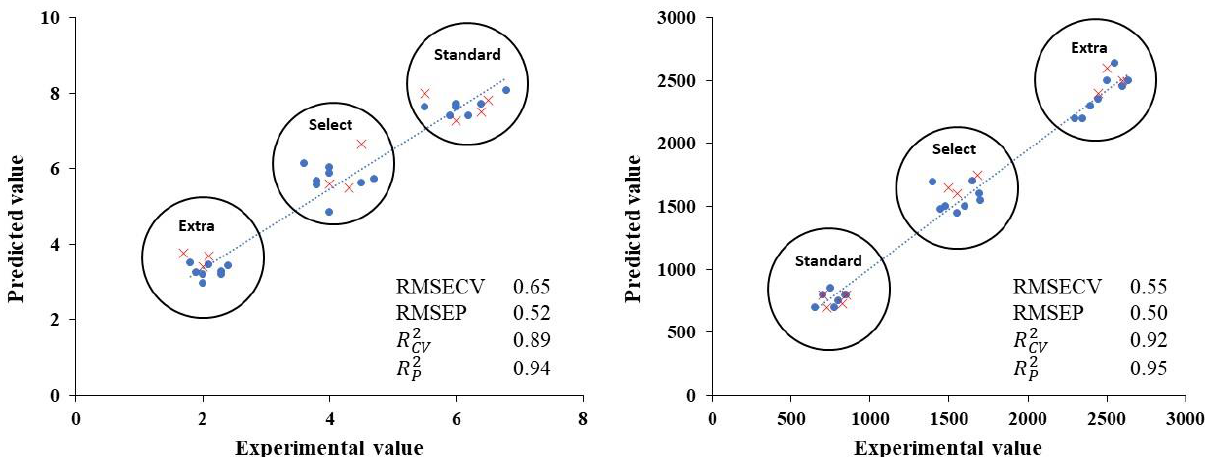
Figure 6. Experimental values compared to PLS cross-validation predictions ( • ) and validation set predictions (x) for burn defects in aromas perceived by panellists ( left ) and total phenol profiles ( right ).